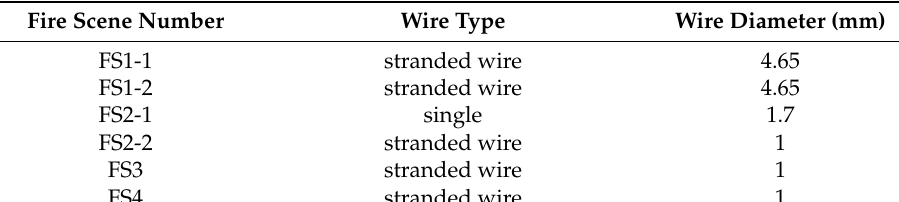
Table 1. Specification of the fire scene samples.